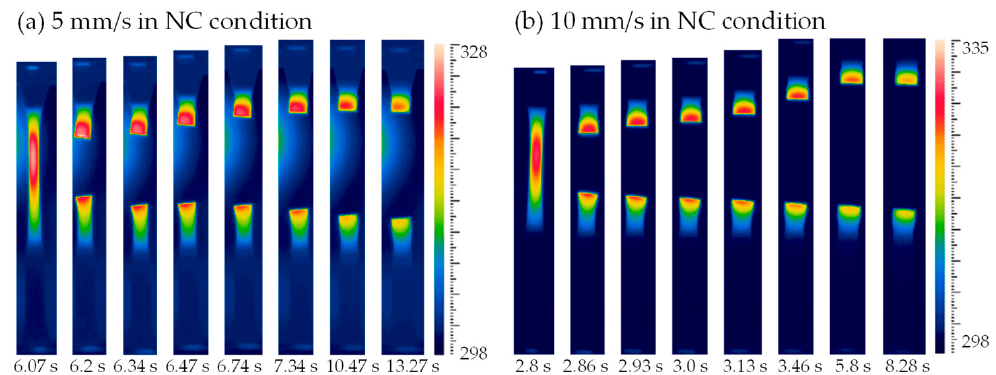
Figure 13 . Temperature contours after fracture at different moments at the loading rates of ( a ) 5 mm/s and ( b ) 10 mm/s in the NC condition.